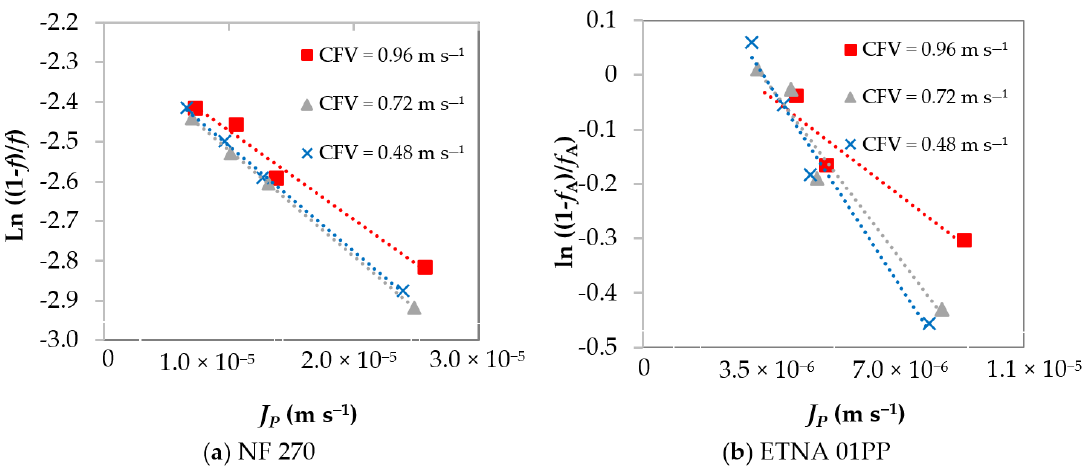
Figure 4. Variation of apparent rejection coefficients with the transmembrane pressure at three cross-flow feed velocities: ( a ) NF 270 membrane; ( b ) ETNA 01PP membrane.